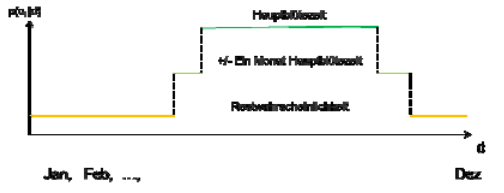
Figure 8: Probabilities for blooming periods (Blütezeit) depending on the date (month) (Source: Oswald Aldrian).